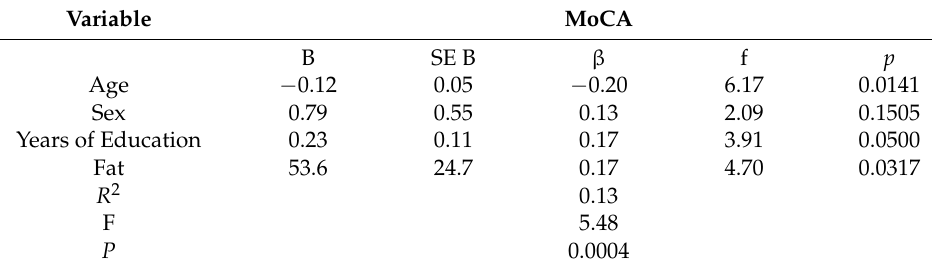
Table 2. Association between the Montreal Cognitive Assessment (MoCA) score and consumption of fat.